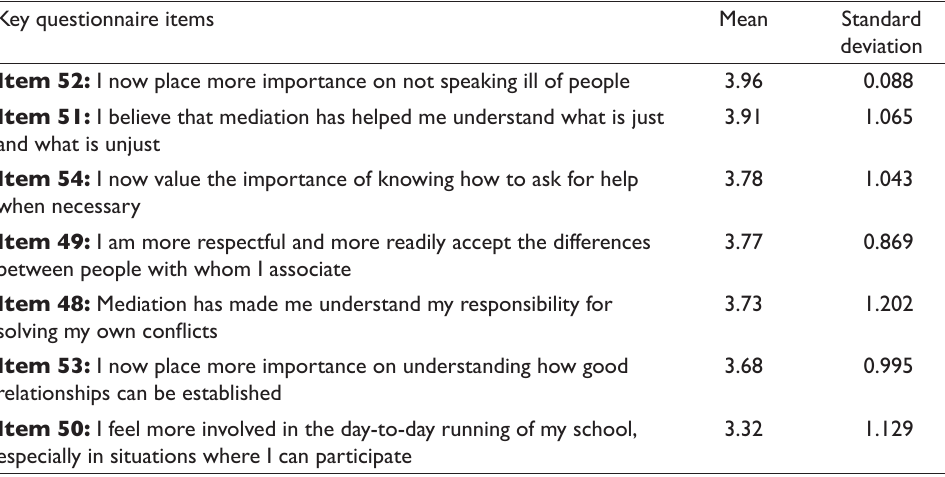
Table 5: Means and standard deviations on socio-moral aspects found among mediated